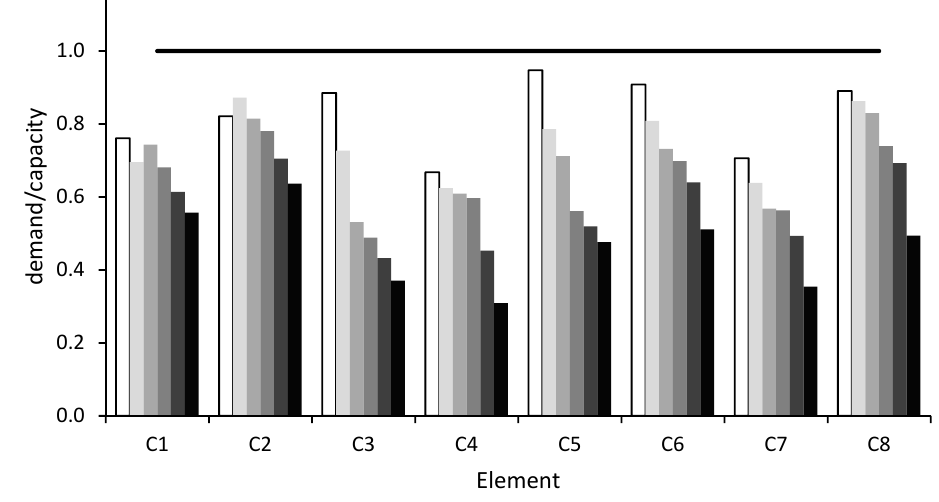
Figure 22. Ductile verifications after retrofit of columns.